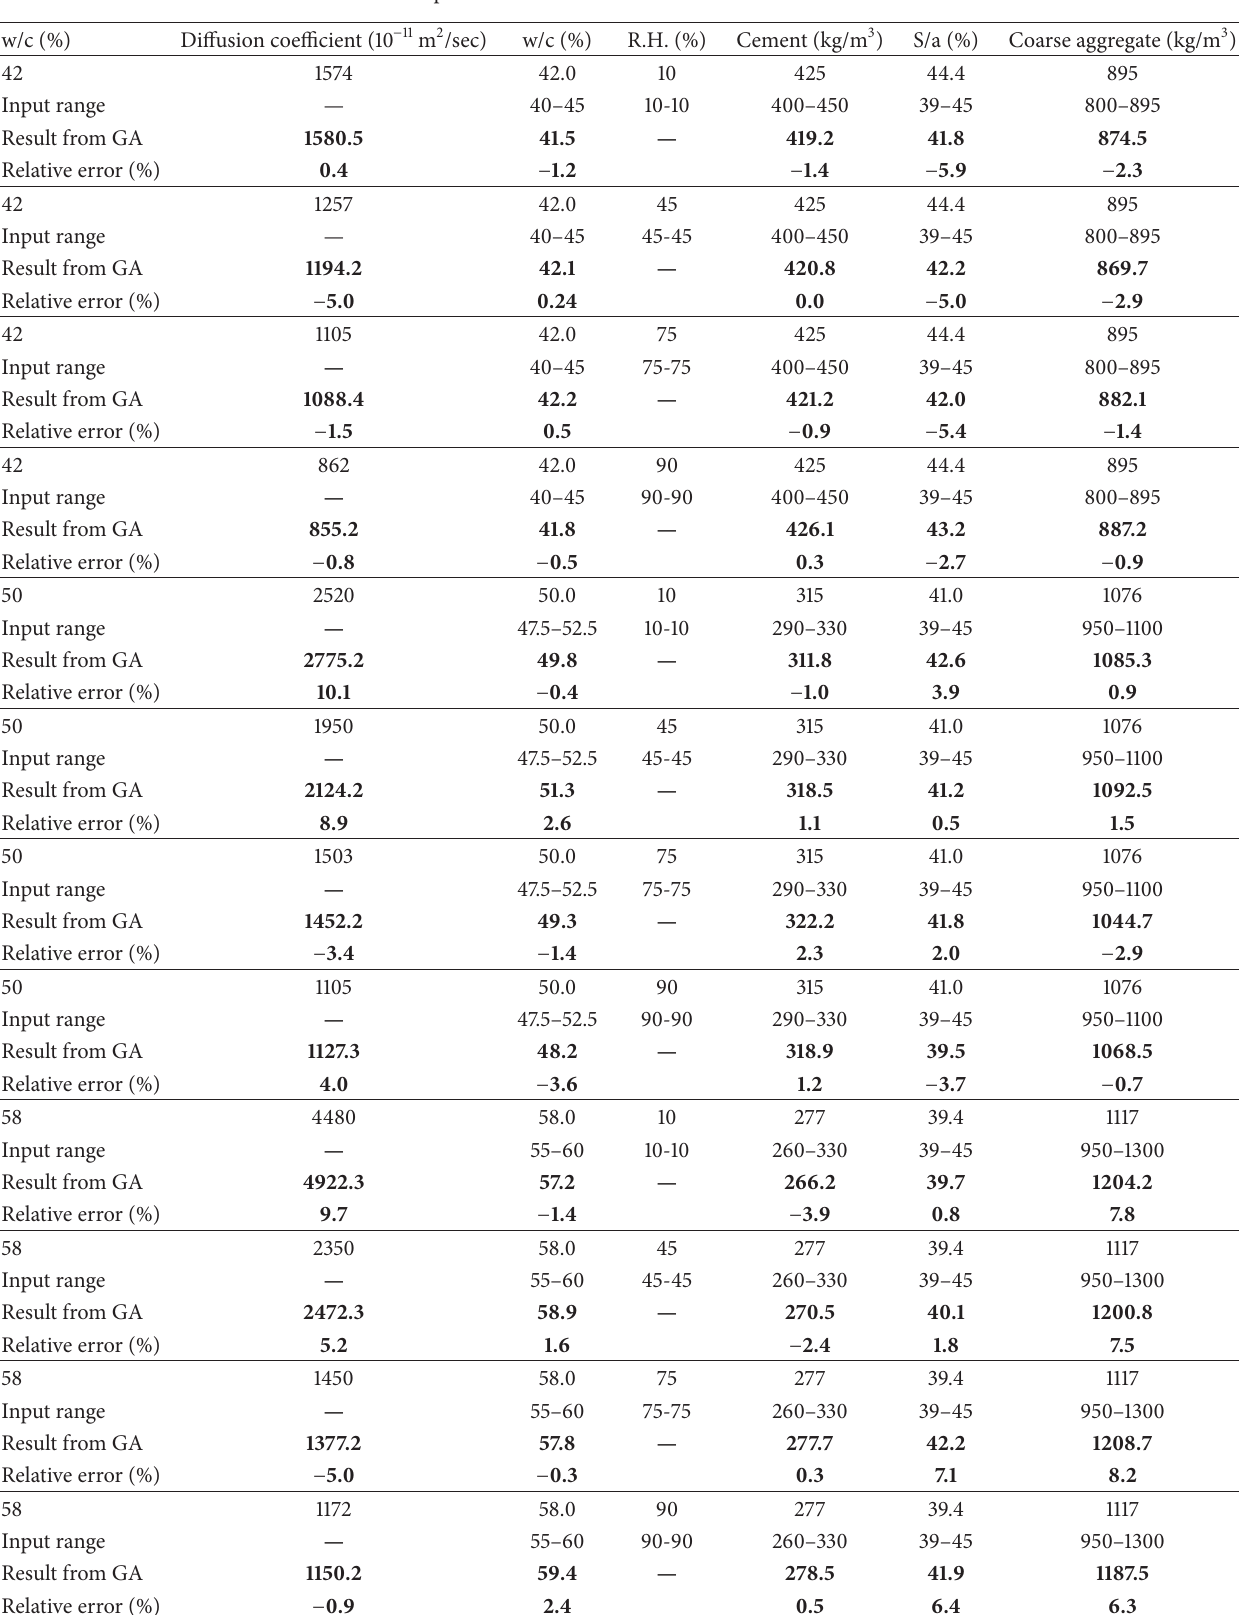
Table 7: Comparison with results from test and simulation from